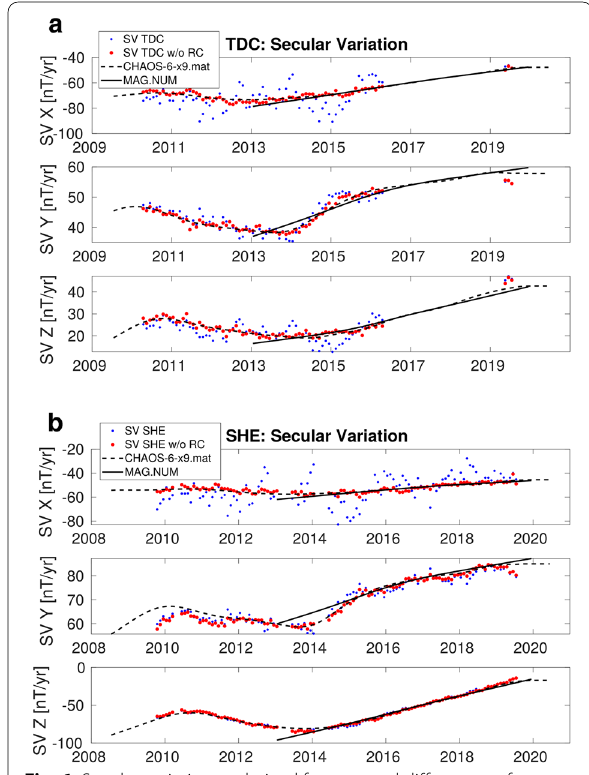
Fig. 6 Secular variation as derived from annual differences of observatory monthly means of a Tristan da Cunha (TDC) and b Saint Helena (SHE) geomagnetic observatories of the geocentric North (X), East (Y) and Vertical (Z) component (blue points). In addition, the external field description from the CHAOS6-x9 model was used to remove contributions of the magnetospheric ring current (RC), as shown by the red points. The black solid lines show the Mag. num IGRF parent model. The dashed lines are predictions from the CHAOS-6x9 model for